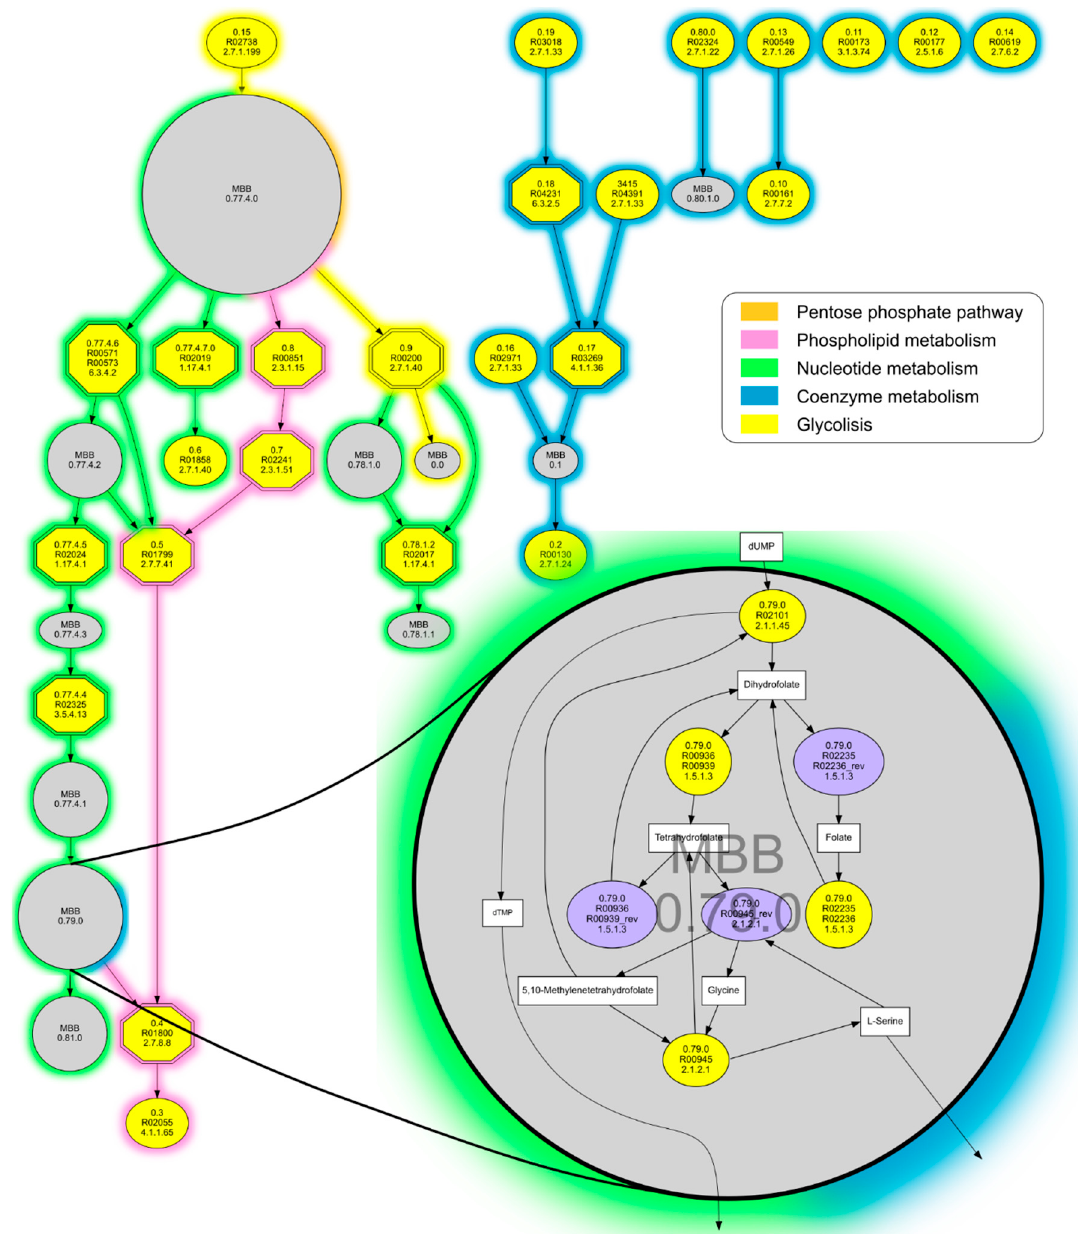
Figure 3. m ‐ DAG of the metabolism of a theoretical minimal bacterial cell. Single reactions appear in yellow, contracted MBBs in grey, and the essential reactions as hexagons with double lines. Line colors denote metabolic categories. MBB 0.79.0 is zoomed in as an example of how a strongly connected component, which is a cyclic subgraph formed by 7 reactions and 7 compounds, is reduced to one node in our m ‐ DAG. Table 2. Essential reactions of the m ‐ DAG constructed from the theoretical minimal gene set ma ‐ chinery needed for life.